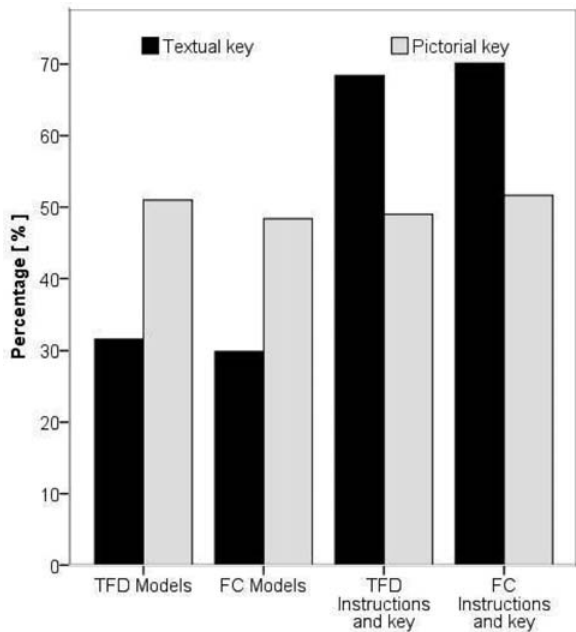
Figure 5. Sum of the relative mean values of TFD and FC on AOI- s of pictorial or text explanatory